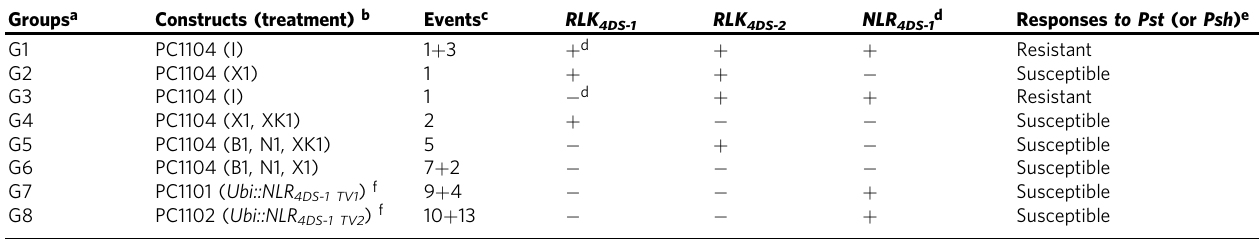
Table 2 Transgene expression and plant responses to Puccinia striiformis Groups a Constructs (treatment)